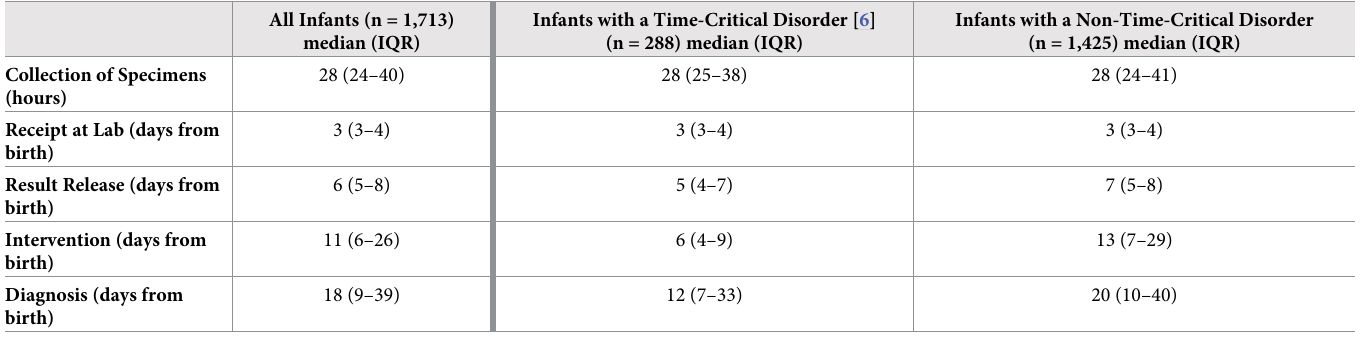
Table 6. Timeliness metrics for newborns identified with a disorder on the newborn screening panel. All Infants (n = 1,713) Infants with a Time-Critical Disorder [6] median (IQR) (n = 288) median (IQR)